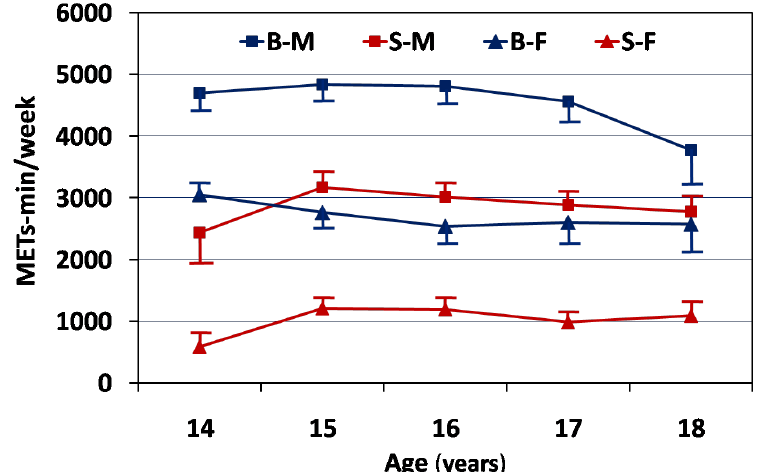
Figure 1. Total energy expenditure from physical activity among Saudi and British adolescents.